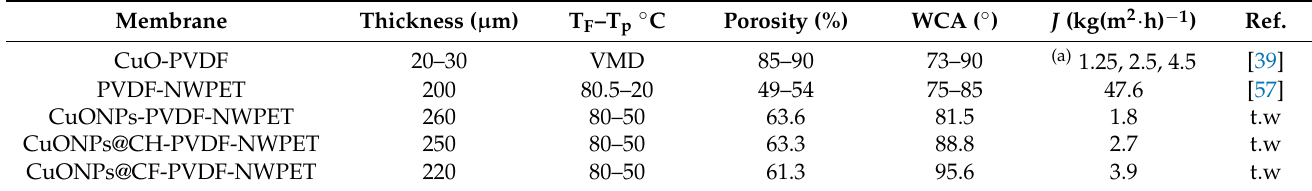
Table 1. Comparison of flux results with similar systems reported in